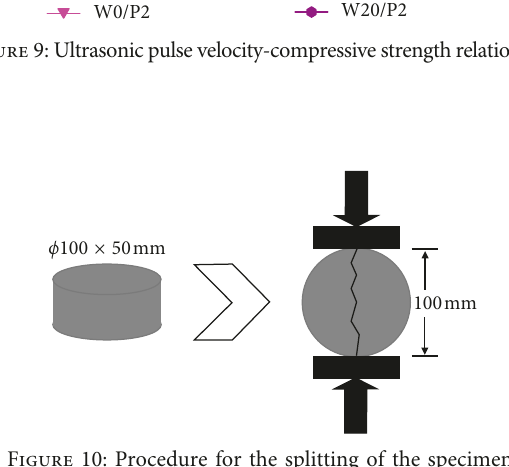
Figure 11: Nonsteady state migration coefficient of mortar